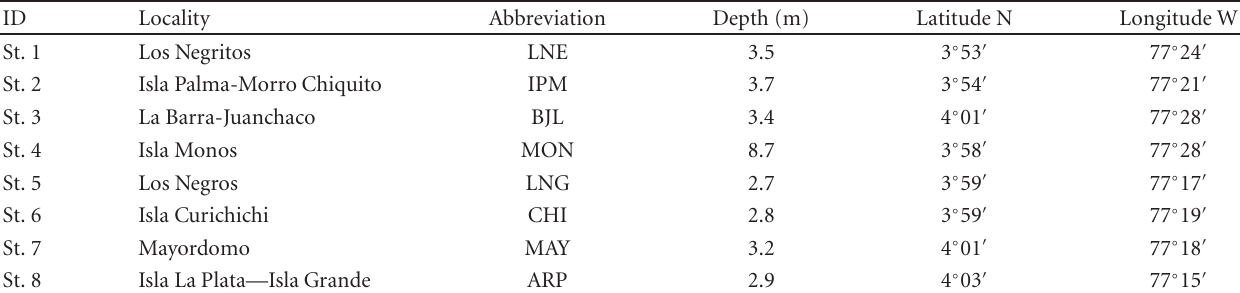
Figure 1: Study area: Bahia M´alaga, Pacific coast of Colombia, the black dots correspond to the sampling stations. Table 1: Geographical localization, abbreviations, and average depth of studied